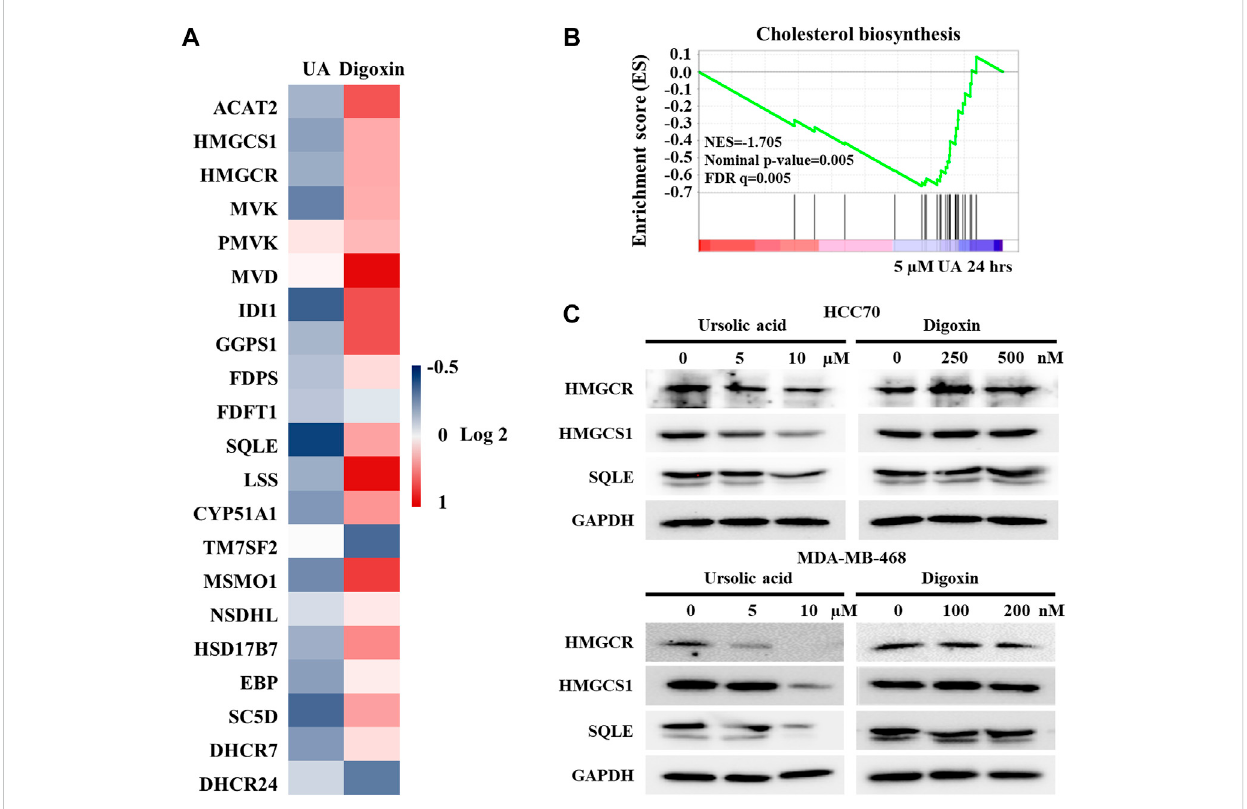
FIGURE 6 Expressions of cholesterol biosynthesis genes were altered by ursolic acid in TNBC cells. (A) . Heat map display of fold changes (in log 2) in mRNA expression of 21 cholesterol-biosynthesis genes in HCC70 cells treated by 5 µM UA (RNA-seq) or 250 nM digoxin (qPCR) for 24 h. (B) . GSEA of genes involved incholesterol-biosynthesis pathway inHCC70cell treated with 5 µM UA for 24 h. NES, normalized enrichment score. FDR, false-discovery rate. (C) . Immunoblotting of HMGCR, HMGCS1, SQLE and GAPDH in HCC70 and MDA-MB-468 cells treated with UA or digoxin at indicated concentration for 48 h. Representative blots, n =